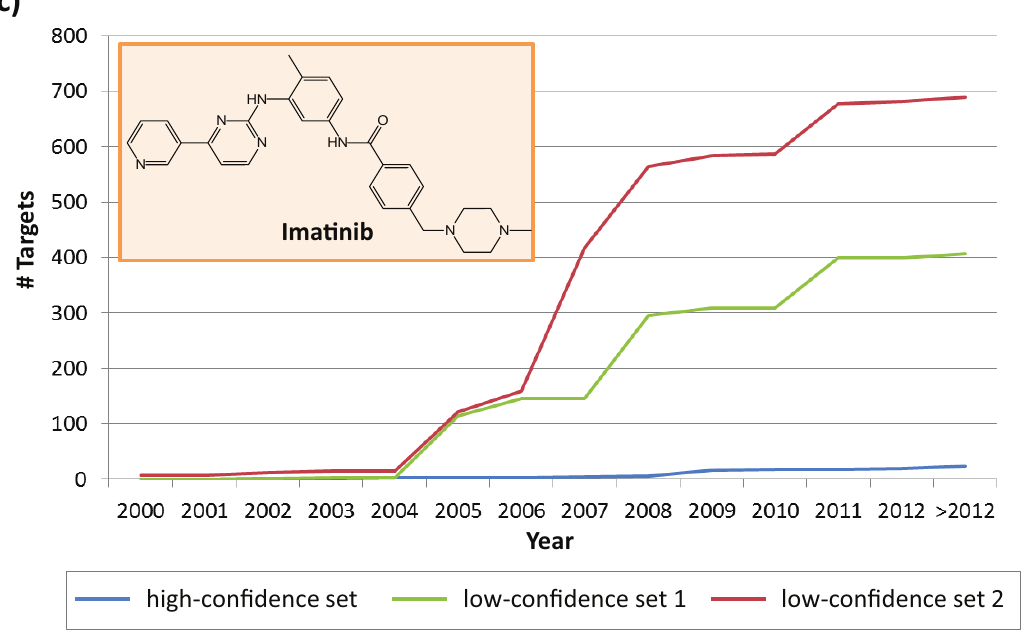
Figure 9. Drugs in sets with varying activity confidence levels. ( a ) Reported is the cumulative number of drugs in three data sets of varying confidence levels over time. ( b ) Shown is the distribution of average promiscuity rates for drugs in these three data sets. ( c ) For imatinib, the cumulative number of targets is reported for different years.